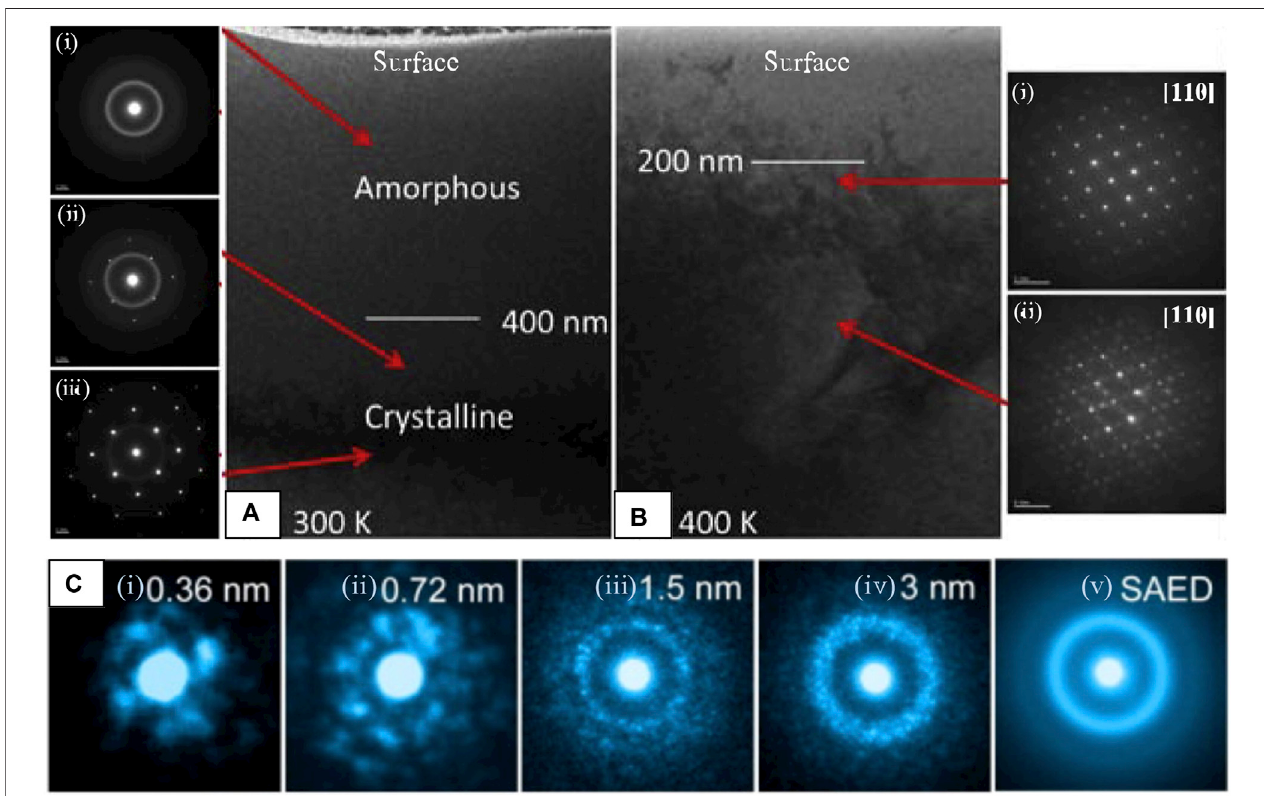
FIGURE 11 | Small (nm- or Å-scale) quasi-parallel electron probes to acquire highly localized diffraction information to (A,B) assess crystallinity as a function of depthand (C) todemonstratetheeffectofprobesizeindetectionoflocalatomicorderinginanamorphoussolid. (A) BF-TEMofanion-irradiatedYb 2 TiO5cross-section held at (A) 300 K,NBED showing loss of crystallinity at the (i) surface and (B) 400 K, NBEDshowing (i) absence ofthe (111) pyrochlore re fl ection which (ii) reappearsat depth, reproduced from (Aughterson et al., 2018) (C) The effect ofincreasing probe sizein aZr 66.7 Ni 33.3 metallic glass, where local atomic ordering emergesat the smallest (Å-scale) probe sizes, averaging out into a smooth, diffuse ring as the probe size increases. Reproduced from reference (Hirata and Chen,